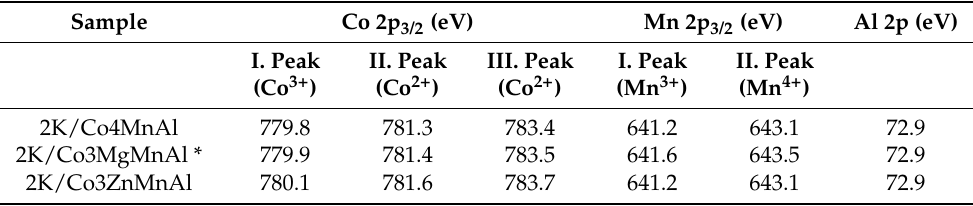
Table 2. Binding energies ( ± 0.2 eV) of Co 2p 3/2 , Mn 2p 3/2 , and Al 2p peaks for